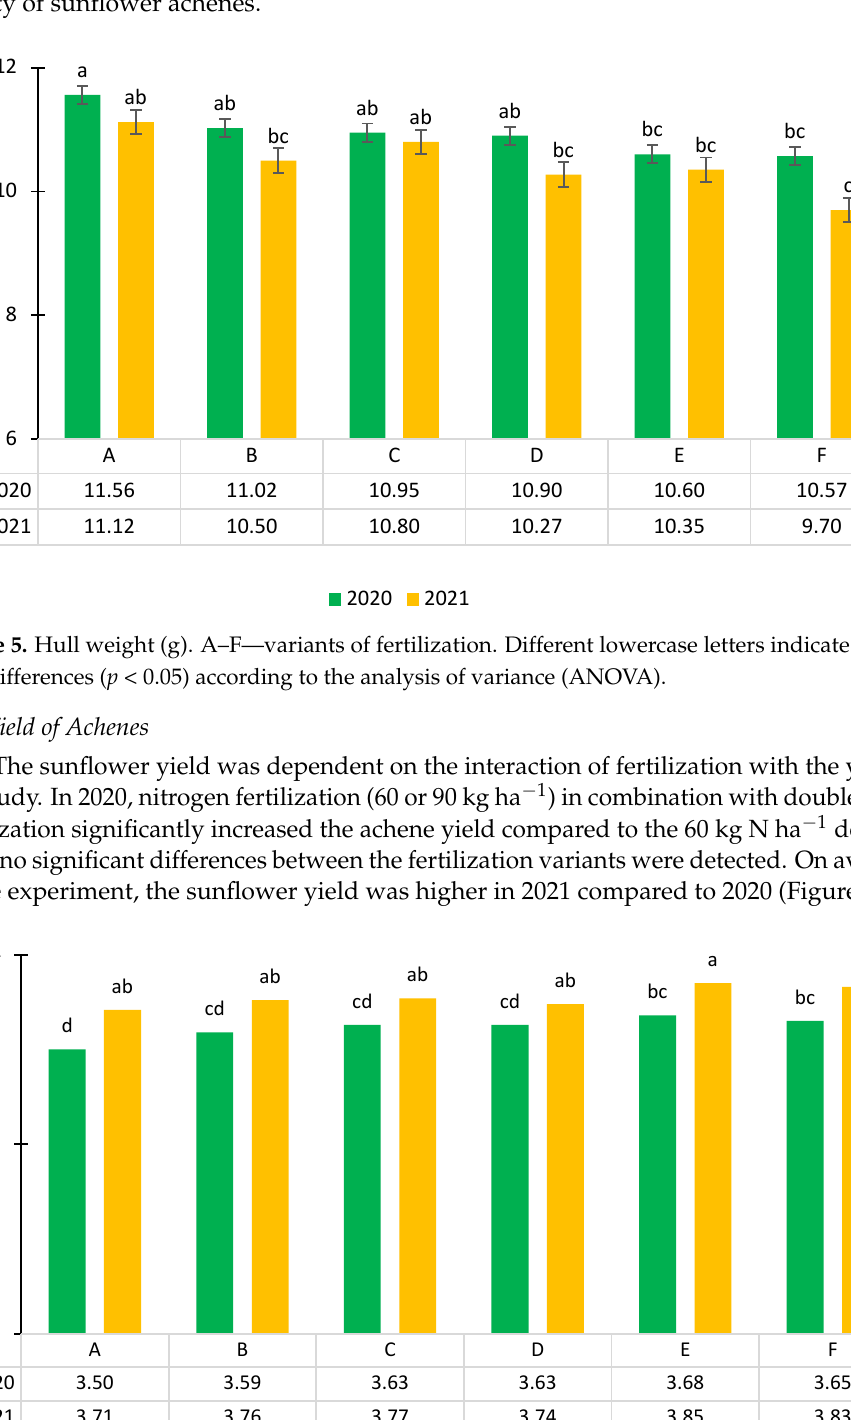
mine the quality of sunflower achenes.